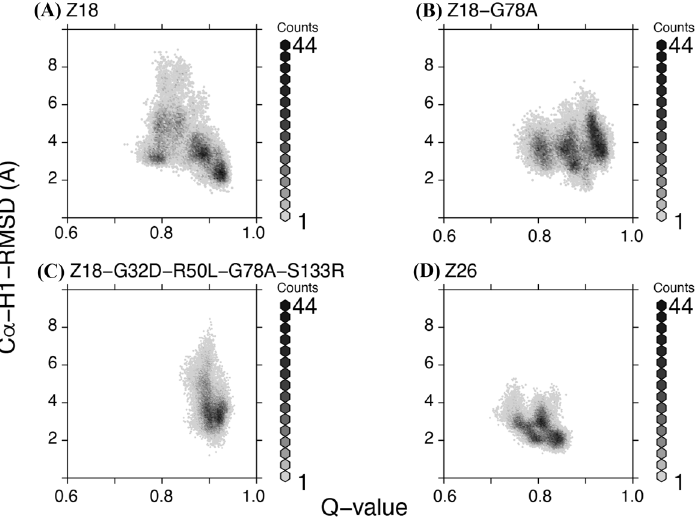
Figure 4. Conformational space explored correlates with thermal stability. Plots of Q-value versus Cα-RMSDs of CDR-H1 of indicated single-domain V H H antibodies. The last 500 ns trajectories of five simulations were merged in each